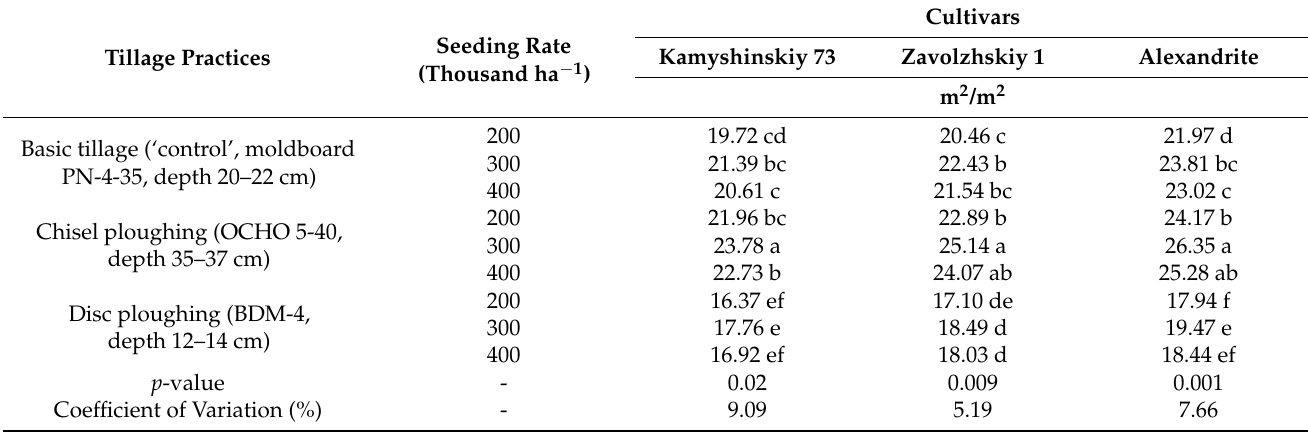
Table 1. Interactive efficacy of the various tillage practices and seeding rates on safflower maximum leaf area index (LAI) average in